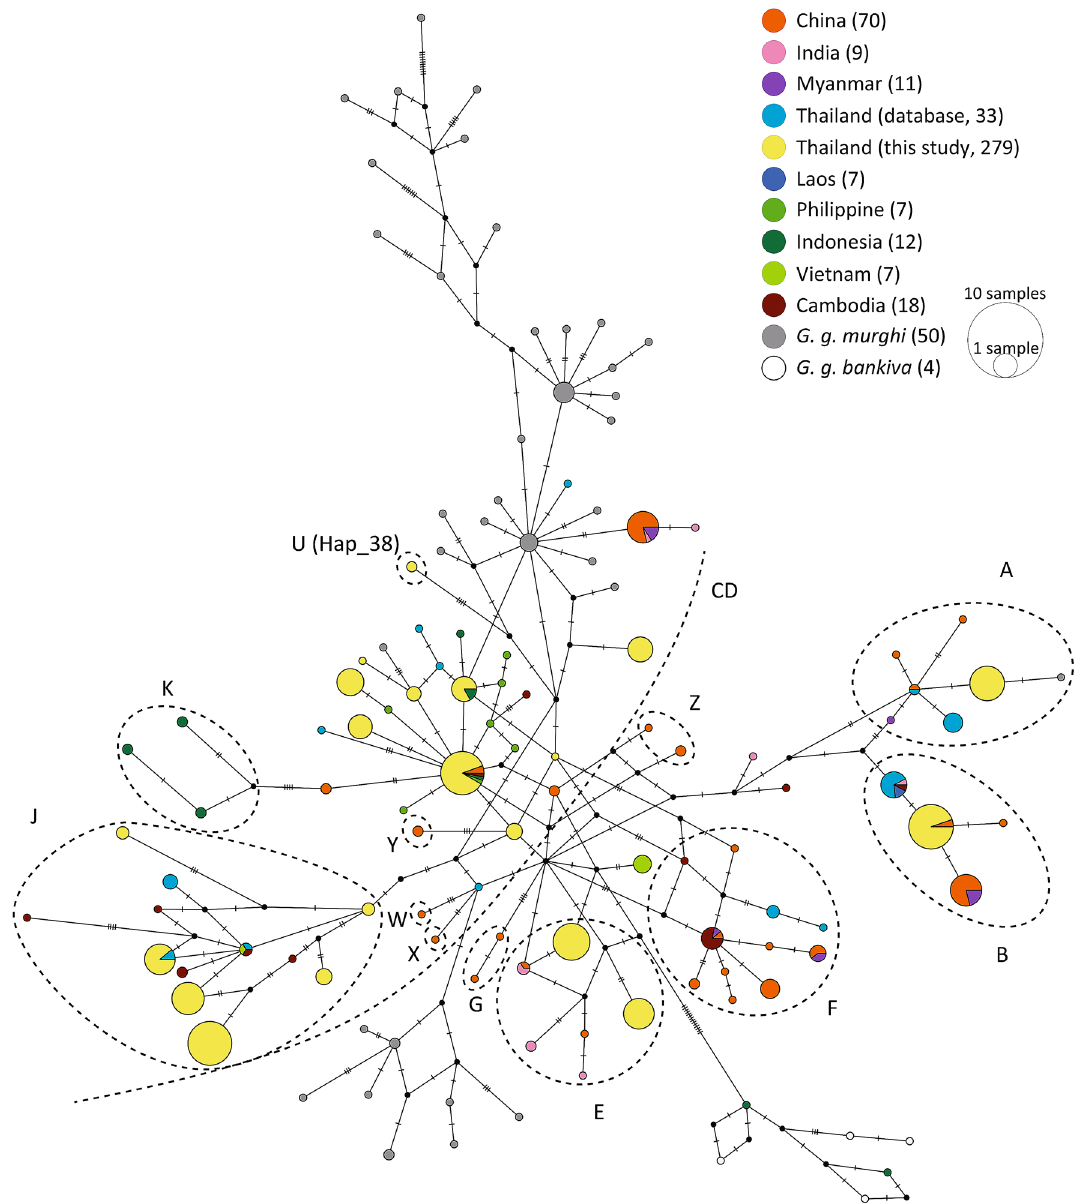
Figure 3. Median-joining haplotype network of mtDNA D-loop sequences of red junglefowl. The haplotypes are approximately subdivided into 12 haplogroups, A, B, CD, E, F, G, J, K, W, X, Y, and Z, and unclassified haplotypes (U) in this network, according to the haplotype classification by Miao et al. 5 and the present study. The sizes of circles indicate relative frequencies of haplotypes, and the number of bars on the lines, which link haplotypes, represent the number of nucleotide substitutions that occurred between the haplotypes for comparison. Black nodes are the inferred intermediate haplotypes. The geographic origins of haplotypes or subspecies names are shown using circles with different colours. The numbers in parentheses after the location or subspecies names indicate the numbers of sequences used for analyses. Detailed information on the sequences obtained from the database are listed in Supplementary Table Genetic relationships among indigenous chicken breeds and red junglefowl in Thailand. Two cladograms based on Da and Dxy genetic distances constructed with mtDNA D-loop sequences exhibited simi- lar topologies (Fig. 4a,b); six breeds of Thai indigenous chickens (LHK, CH, PHD, KP, Decoy, and fighting chicken) and the DT chicken breed showed close genetic relationships in both trees, whereas three other Thai indigenous chicken breeds (BT, NK-W and NK-B) were phylogenetically located far from the six breeds. Two red junglefowl subspecies were not phylogenetically separated from each other. However, the phylogenetic tree based on the F ST genetic distance constructed using microsatellite markers indicated that all red junglefowl pop- ulations excluding Huai Sai (Ggg) and Huai Sai (Ggs) had a close genetic relationship (Fig. 4c). Five indigenous